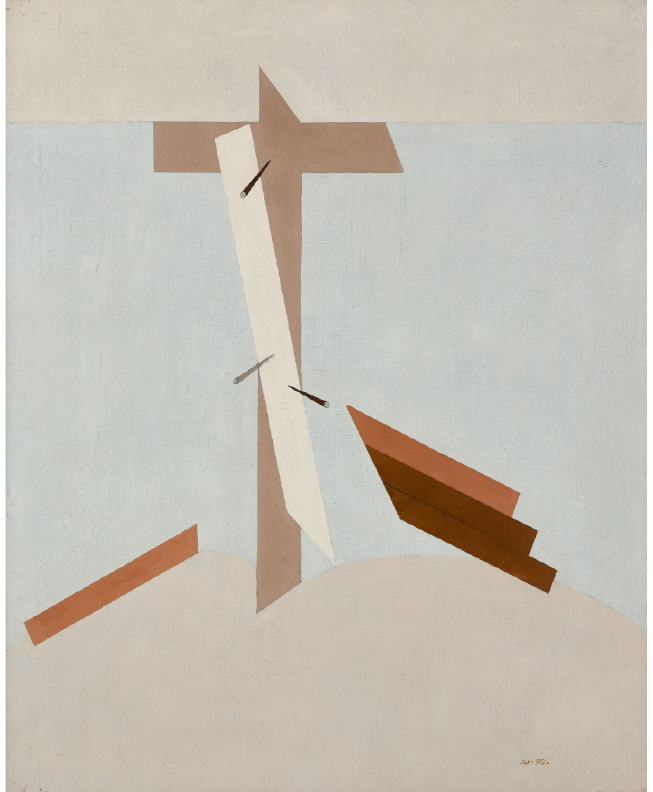
Figure 7. Eduard Steinberg. A Composition. 1975–77. Oils on canvas, 100 * 90 cm. Denis Khimi- lyaine’s collection. https://deniscollection.com/eduard-steinberg/composition-1975-5/ (accessed